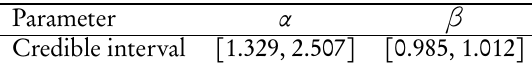
95% credible intervals of the